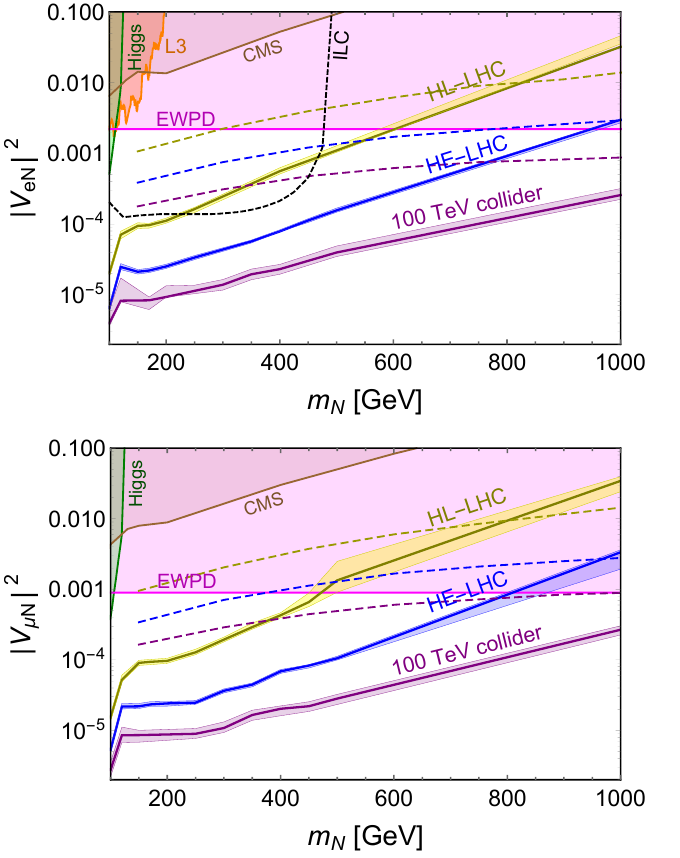
Figure 14 . Sensitivities of the heavy-light neutrino mixing | V eN | 2 (upper) and | V µN | 2 (lower) at 95% C.L. as function of heavy neutrino mass m from the ML analysis of the trilepton signal in N eq. (2.4). The solid darker yellow, blue and purple lines correspond, respectively, to the central values of sensitivities at the HL-LHC 14 TeV with a luminosity of 3 ab − 1 , HE-LHC 27 TeV with 15 ab − 1 and the 100 TeV collider with 30 ab − 1 . The lighter color bands are due to the systematic uncertainties. The dashed lines are the corresponding sensitivities using dynamic jet vetoes from ref. [80]. The dashed black line in the upper panel is the sensitivity at the ILC 500 GeV with 500 fb − 1 . The shaded regions are excluded by the direct searches of N by L3 (orange) [114, 115], CMS (brown) [116], precision SM Higgs data (green) [117], and the indirect limits from EWPD (magenta) [81–84]. See text for more